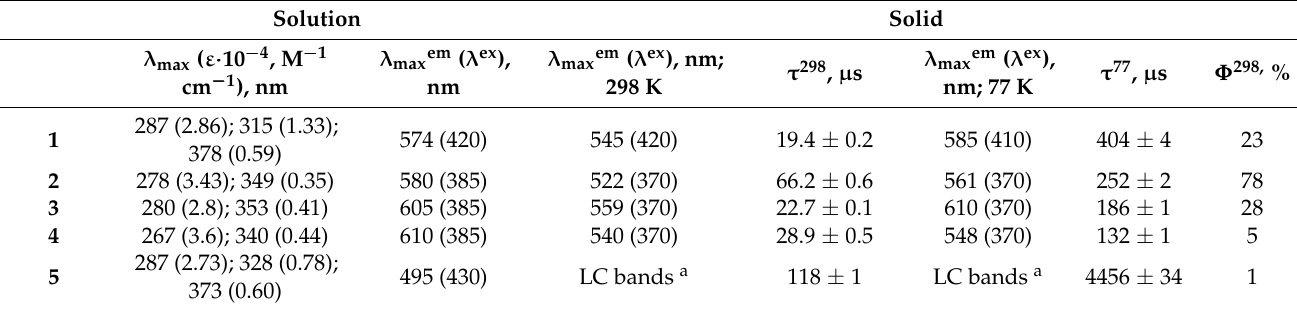
Figure 2. ( a ) UV-vis absorption spectra and ( b ) emission spectra of complexes 1 − 5 in DCE; emission spectra of solid samples 1 − 4 at ( c ) 298 K and ( d ) 77 K; ( e ) emission spectra of solid 5 at 298 and 77 K. Table 2. Photophysical parameters for complexes 1 – 5